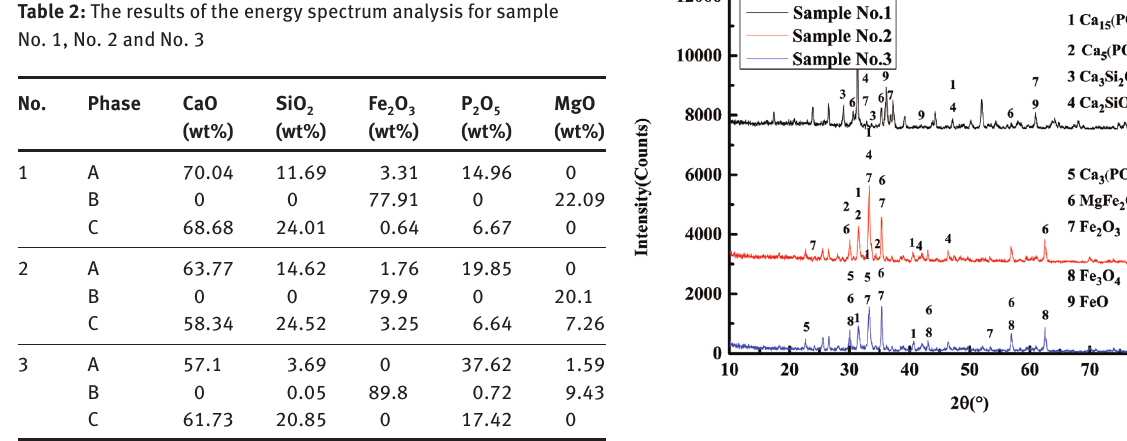
Fig. 3: The results of X-Ray diffraction analysis for sample No. 1, No. 2 and No. 3